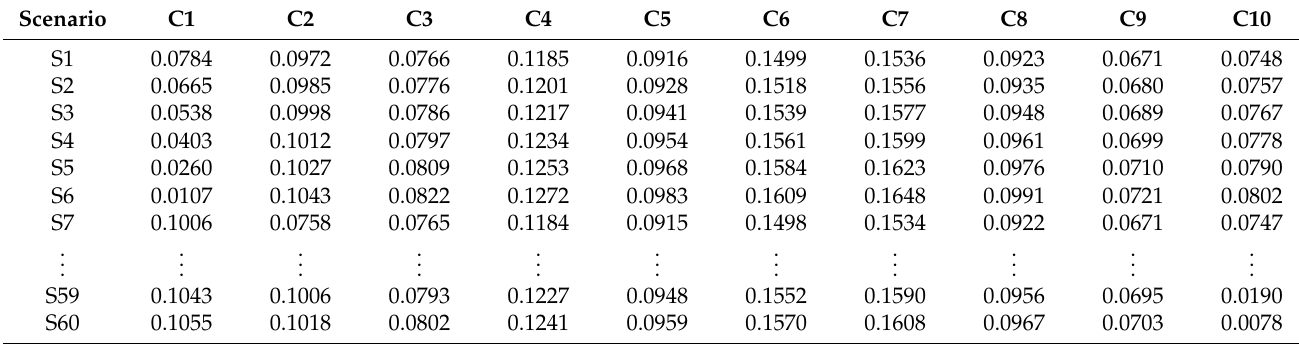
Table 10. Scenarios for carrying out sensitivity